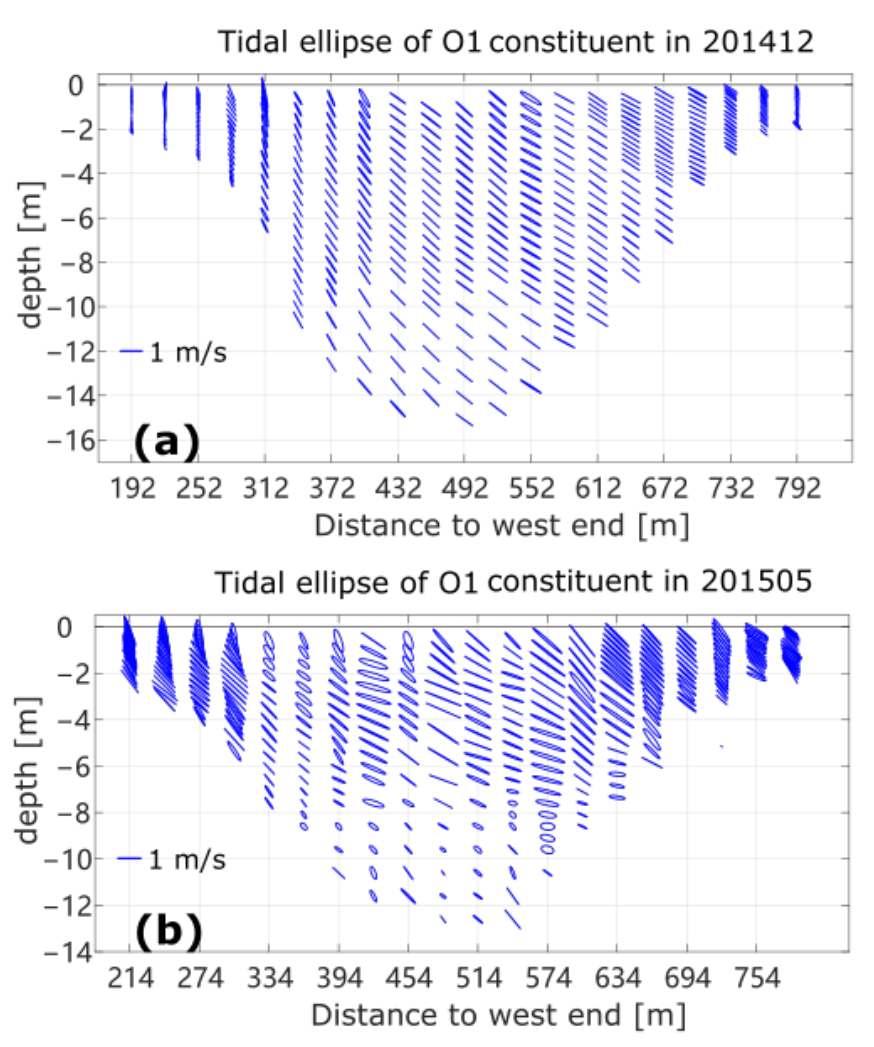
Figure 5. Tidal ellipse of diurnal components in winter observation ( a ) and late spring observation ( b ). The major and minor axes of current ellipses are isometric and shown in north and east directions and the blue bars in lower-left corner are scales of 1 m/s.